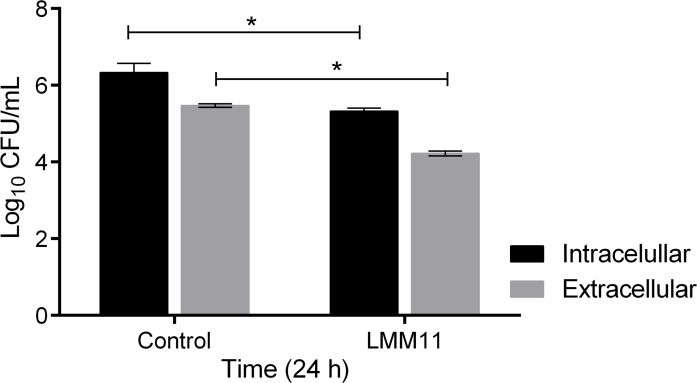
Antifungal activity of LMM11 against intracellular and extracellular C. krusei after phagocytosis by J774-A1 macrophages.After 24 hours, supernatants were collected for the CFU determination of extracellular cells. Alternatively, macrophages were lysed for the CFU determination of intracellular cells. (LMM11) Macrophages with internalized C. krusei cells and incubated with LMM11 at concentration 32 μg/mL. (Control) Macrophages with internalized C. krusei cells and incubated with RPMI-1640 only (untreated). *p<0.05, statistically significant values comparing extracellular or intracellular treated versus extracellular or intracellular untreated. The bars indicate the standard deviation.